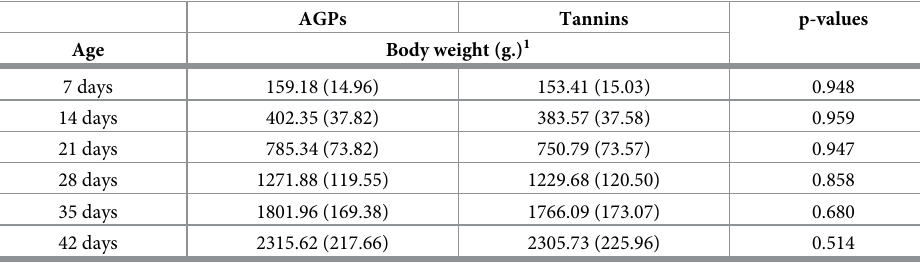
Table 4. Growth performance in broilers under AGPs or tannins programs (experiment